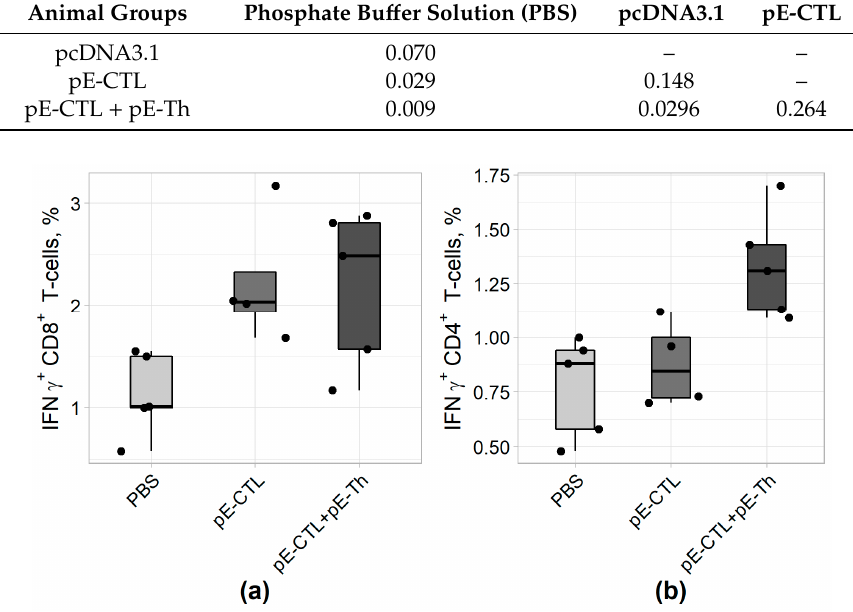
Figure 5. The results of IFN γ -producing CD4 + (A) and CD8 + (B) T-cell count using intracellular cytokine staining (ICS) approach in BALB / c mice immunized with DNA vaccine constructs encoding target immunogens (n = 5).